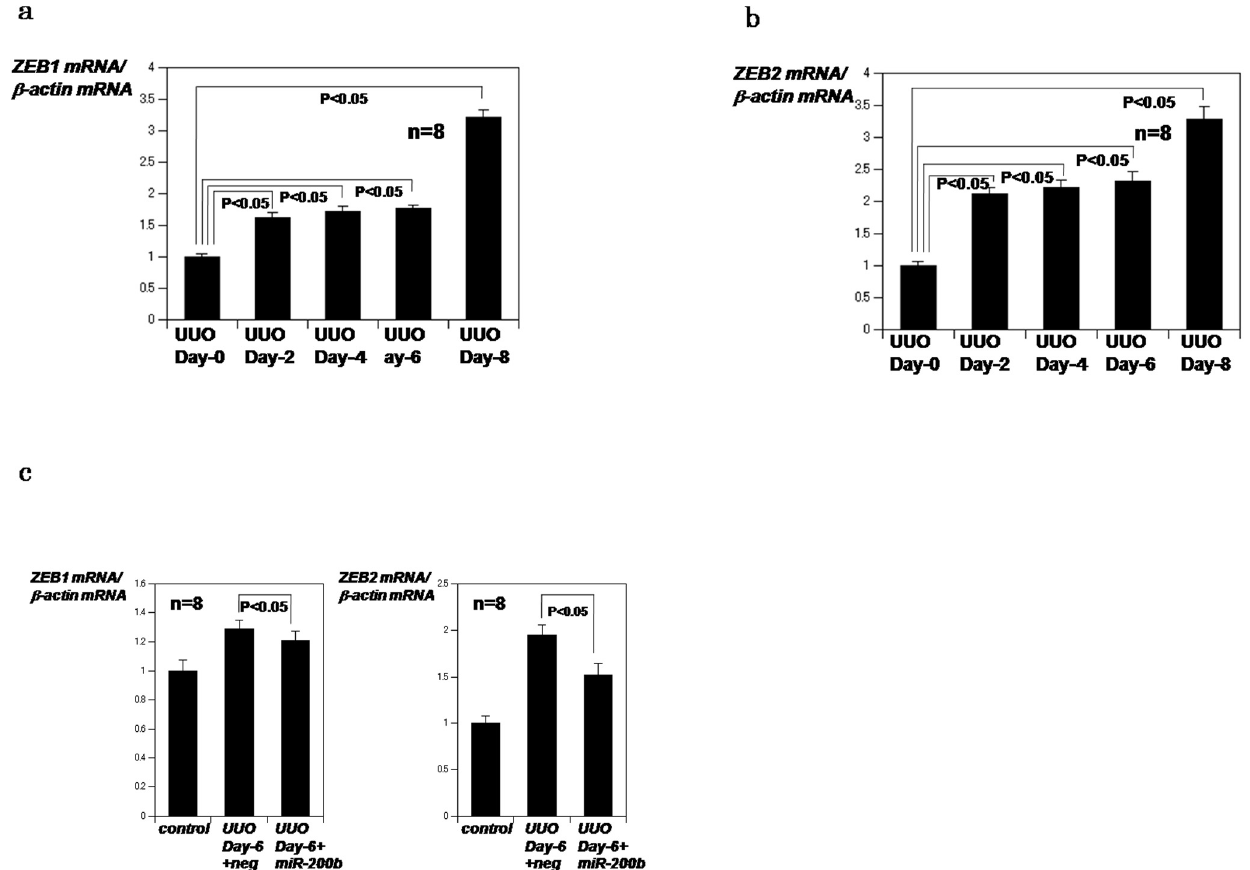
Figure 4. ZEB1 and ZEB2 expression in UUO model mice. a , b , Real time PCR analysis of ZEB1 or ZEB2 mRNA in kidneys obstructed for 2,4,6 or 8 days. The data are normalized to beta-actin mRNA and shown as mean 6 S.E.(n=8). P , 0.05: kidneys obstructed for 2,4,6 and 8 compared with 0 day c , Real time PCR analysis of ZEB1 or ZEB2 mRNA in obstructed for 6 days after i.v. administration of miR-200b precursor. The data are normalized to beta-actin mRNA and shown as mean 6 S.E.(n=8). P , 0.05: obstructed for 6 days after i.v. administration of miR-200b precursor compared with negative control pre-miR.